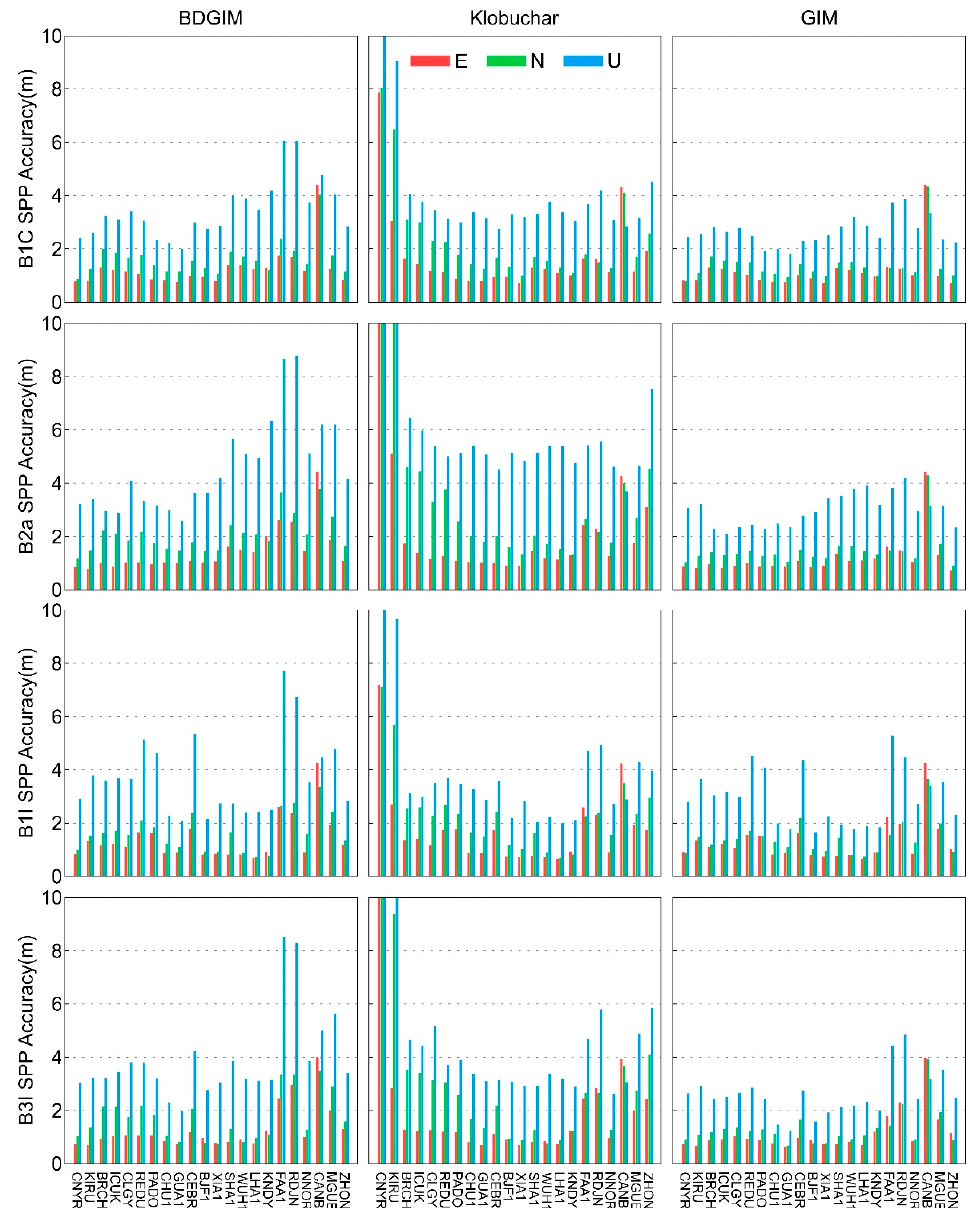
Figure 4. The east (red), north (green) and up (blue) accuracies of SPP with the BDGIM (left), the Klobuchar model (middle) and the GIM (right) using the signals of B1C, B2a, B1I and B3I at the selected 22 stations, which are sorted by latitude from north to south.